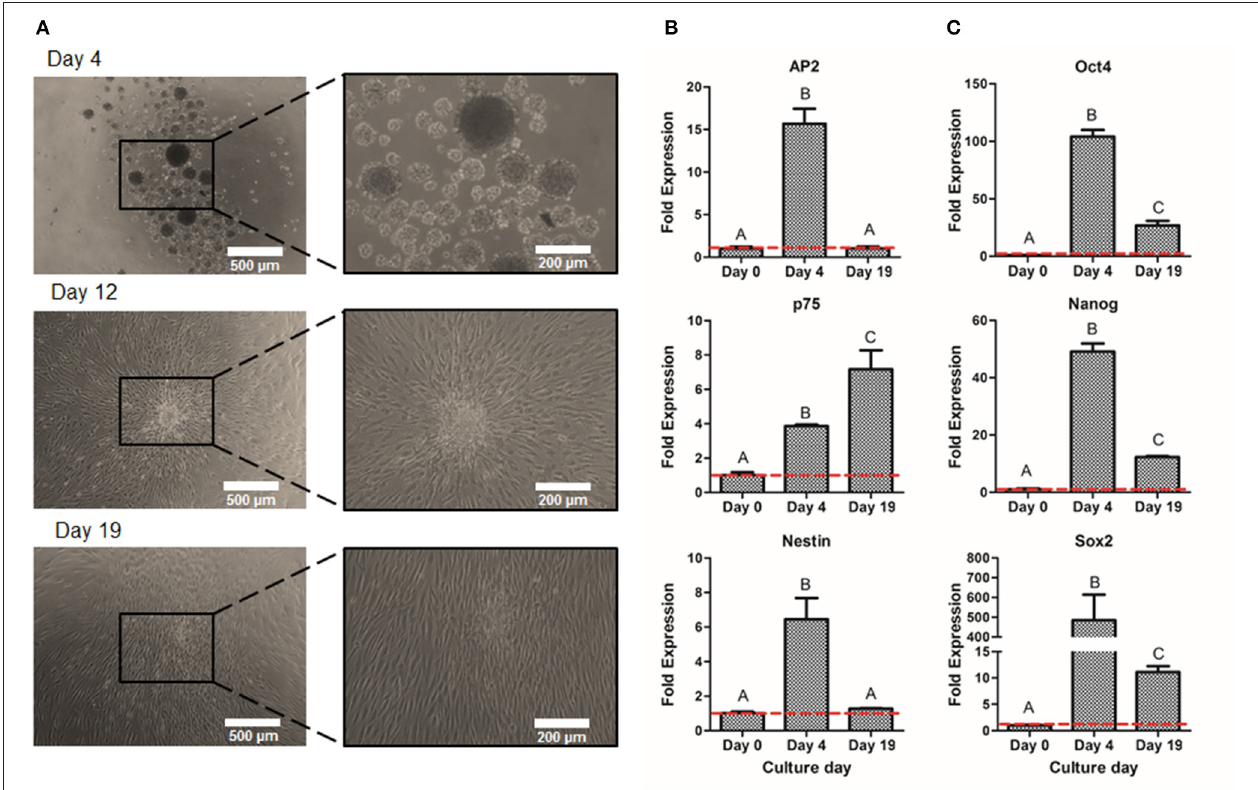
FIGURE 6 | Expansion of NCSC from DPSC. Microscope images of NCSC-derived from DPSC at days 4, 12, and 19 (A) . Relative mRNA expression in NCSC-derived from DPSC, at days 0, 4, and 19 of NCSC markers AP2, Nestin, and p75 (B) and of pluripotent markers Oct4, Nanog, and Sox2 (C) , by quantitative RT-PCR. *Scale bars: 500 µ m (lower magnification) and 200 µ m (higher magnification). **Data presented are means ± SD, n = 3 technical replicates. Significant differences compared to day 0 ( p <